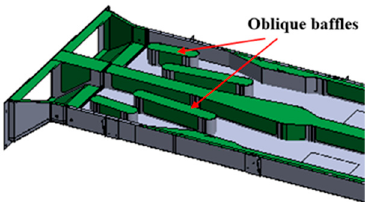
Figure 1. Rectangular ducts used in a Fuxing bullet train.